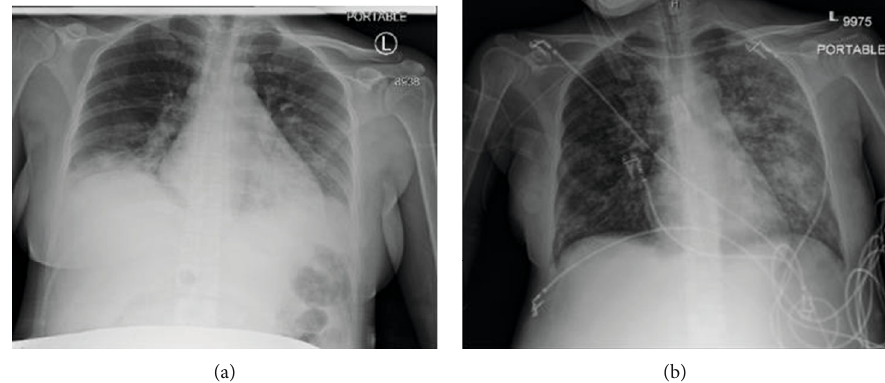
Figure 1: (a) Chest X-ray on admission, showing multifocal consolidative airspace opacities in lung bases bilaterally concerning multifocal pneumonia, possibly secondary to a viral pathogen. (b) Chest X-ray on HD 16 demonstrating generalized patchy bilateral lung airspace disease, with dense opaci fi cation and prominent interstitial lung markings representing the sequelae of